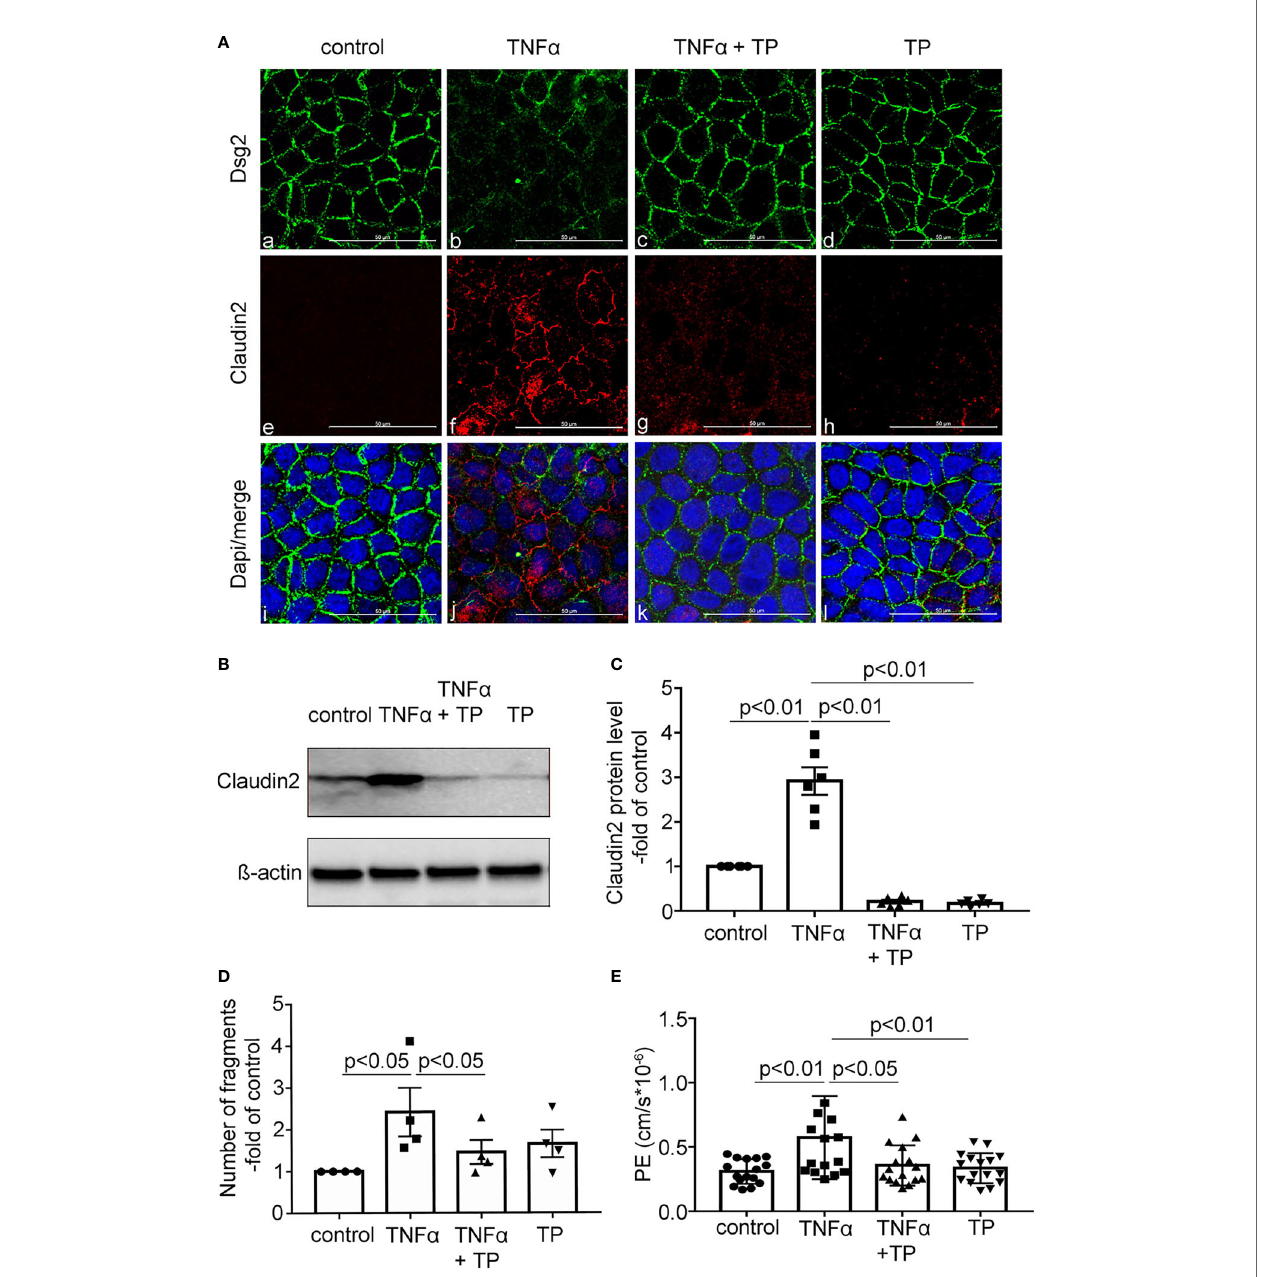
FIGURE 3 | TP attenuated TNF a -induced redistribution of Dsg2 and Cld2 in vitro . (A) Representative immuno fl uorescence staining of Caco2 cells after 24h treatment with either TNF a (100 ng/ml) or TP (20 µM) or both (TNF a +TP) are shown for Dsg2 (green; a-d), Claudin2 (red; e-h) or merged images with DAPI staining (blue; i-l) to visualize cell nuclei. Compared to controls (a,e,i) application of TNF a resulted in reduced Dsg2 (b) and increased Claudin2 (f) at the cell borders. TNF a - induced changes were blunted by application of TP (c,g,k). TP alone had no effect on Dsg2 and Claudin2 (d,h,l) compared to controls. Images shown are representative for n=7, scale bar is 50 µm. (B) Representative Western Blot from Caco2 lysates under the conditions outlined in A for Claudin 2 is shown; ß-actin is shown as loading control. (C) Quantitative analyses of the optical densities for Claudin2 Western Blot bands normalized to b -actin showed a signi fi cant increase of Claudin2 protein levels compared to controls which is attenuated following incubation of cells with TNF a +TP. TP alone has no effect on Claudin2 expression. N= 4 for controls and n=6 for all other experimental conditions; ordinary 1-way ANOVA (D) Results from enterocyte dissociation assays are shown for the same conditions outlined in (A) Incubation of Caco2 cells with TNF a results in increased fragmentation of monolayers whereas TNF a +TP blocked this effect. Effects of TP alone on Caco2 monolayers were absent (p<0.05, n=4, ordinary 1-way ANOVA). (E) Permeability coef fi cient (P E ) measured as 4 kDa FITC dextran fl ux across con fl uent Caco2 monolayers are shown. TNF a -induced increase of epithelial permeability compared to controls (p<0.01) was blocked by application of TP (p<0.05, compared to TNF a ); n=16 for each group; ordinary 1-way